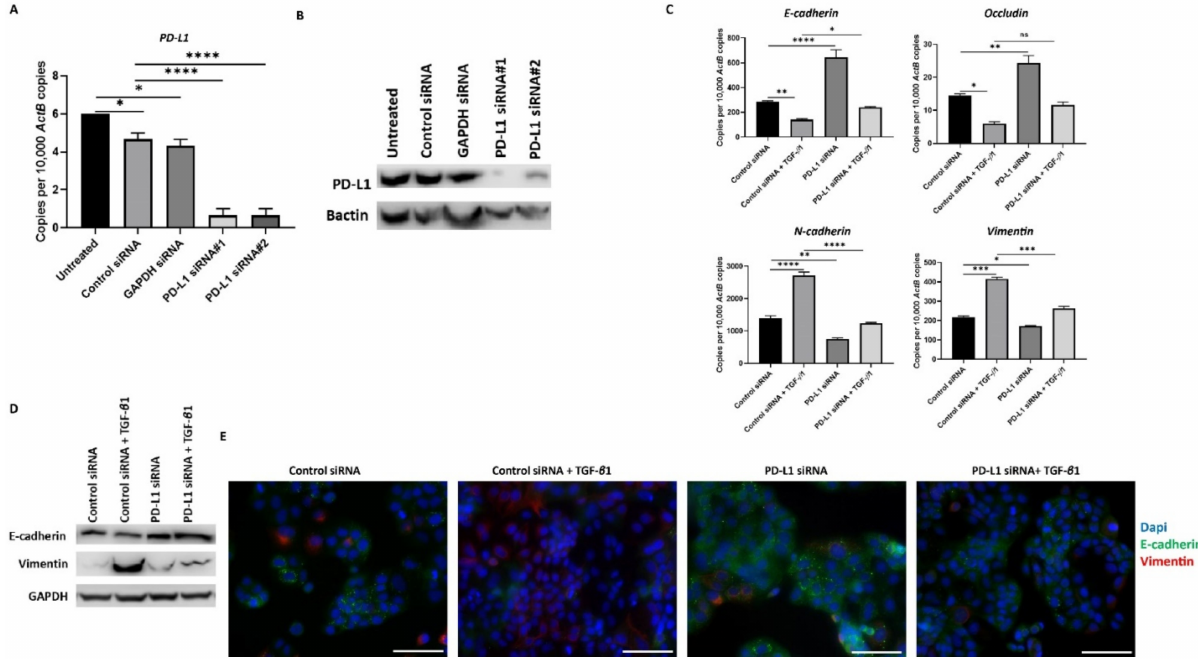
Figure 6. Silencing of PD-L1 reverses TGF- β 1-mediated EMT in PLC/PRF/5 cells. Transfection of HCC cells with two specific PD-L1 siRNA effectively knockdown PD-L1 expression, as demonstrated by ( A ) qRT-PCR and ( B ) western blot analysis. Bactin was utilised as the loading control. ( C ) qRT-PCR demonstrated that silencing of PD-L1 resulted in upregulation of E-cadherin and Occludin along with downregulation of N-cadherin and Vimentin expression in PLC/PRF/5 cells. ( D ) Western blot analysis showed increase in E-cadherin and decrease in Vimentin upon knockdown of PD-L1 in PLC/PRF/5 cells. GAPDH was utilised as loading control in western blot analysis. ( E ) Fluorescence microscopy showed elevation of E-cadherin and decline of Vimentin following PD-L1 knockdown in PLC/PRF/5 cells (scale bar = 200 µ m) ( n = 3, * p < 0.05, ** p < 0.01, *** p < 0.005, **** p <